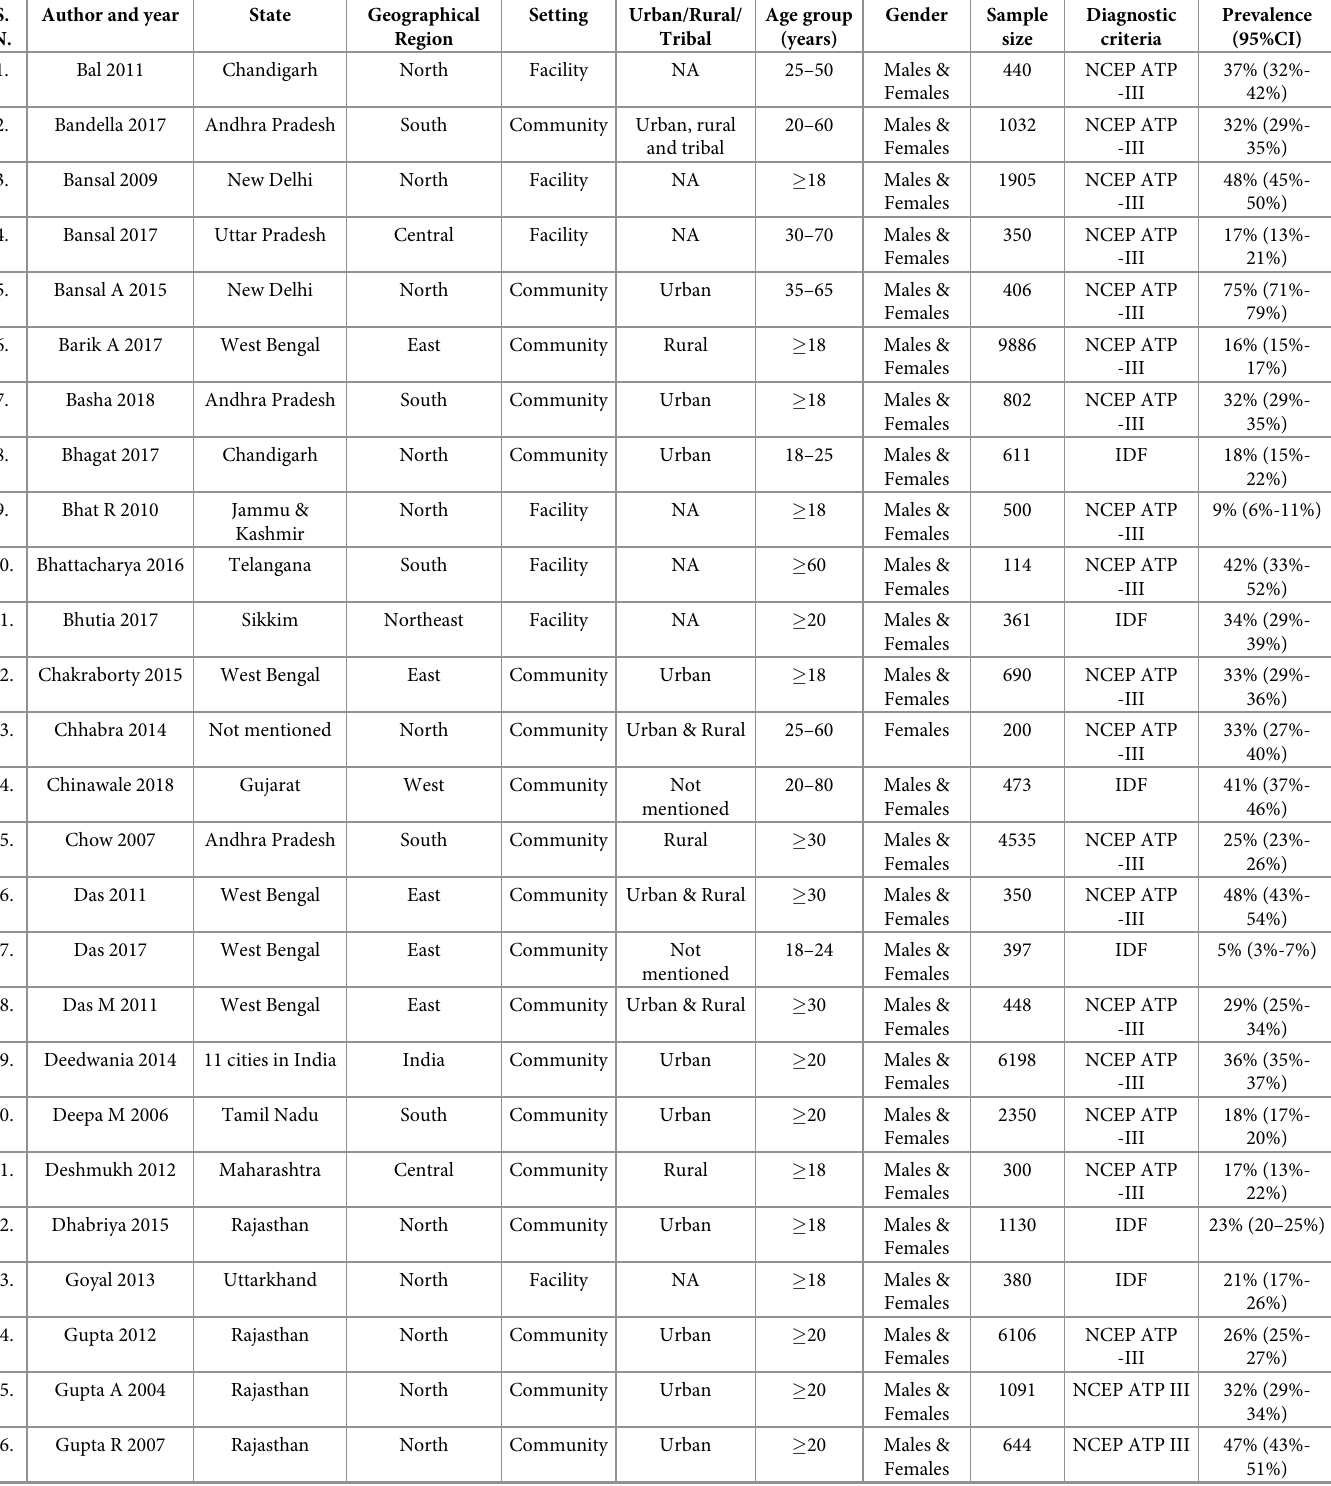
Table 1. Characteristics of the studies included (N =